Question: Identify the chart type used in this figure.
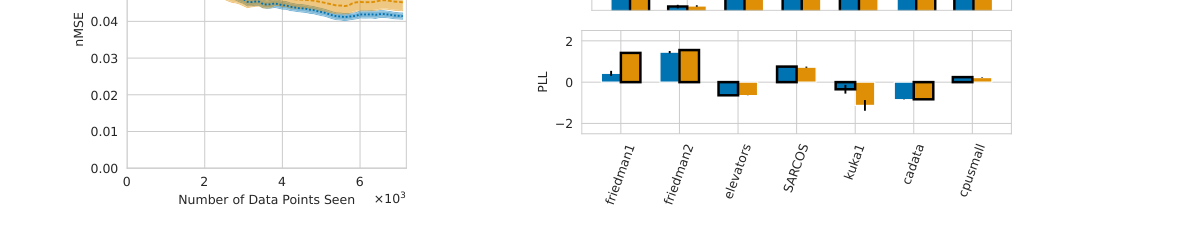
Answer: bar